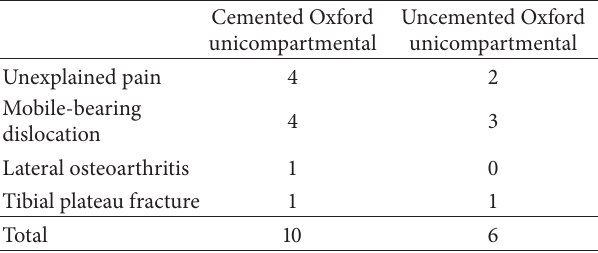
Table 2: Reasons for